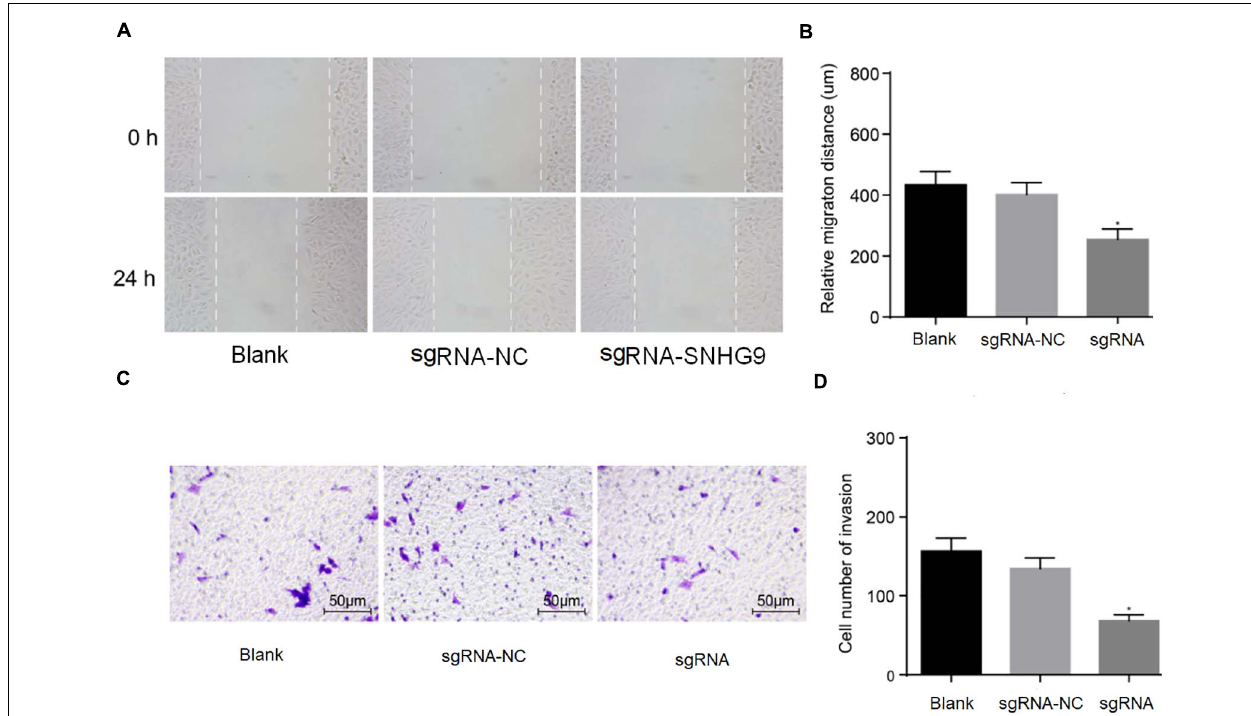
FIGURE 3 | The downregulation of SNHG9 inhibited the migration and invasion of HCC cells. Panles (A,B) were used to detect the cell migration after SNHG9 knockdown by scratch test. (C,D) Cell invasion after SNHG9 gene knockout was detected by Transwell method. Statistical data were presented as mean ± standard deviation, and One-Way ANOVA was used. The experiment was repeated three times; * P < 0.05.